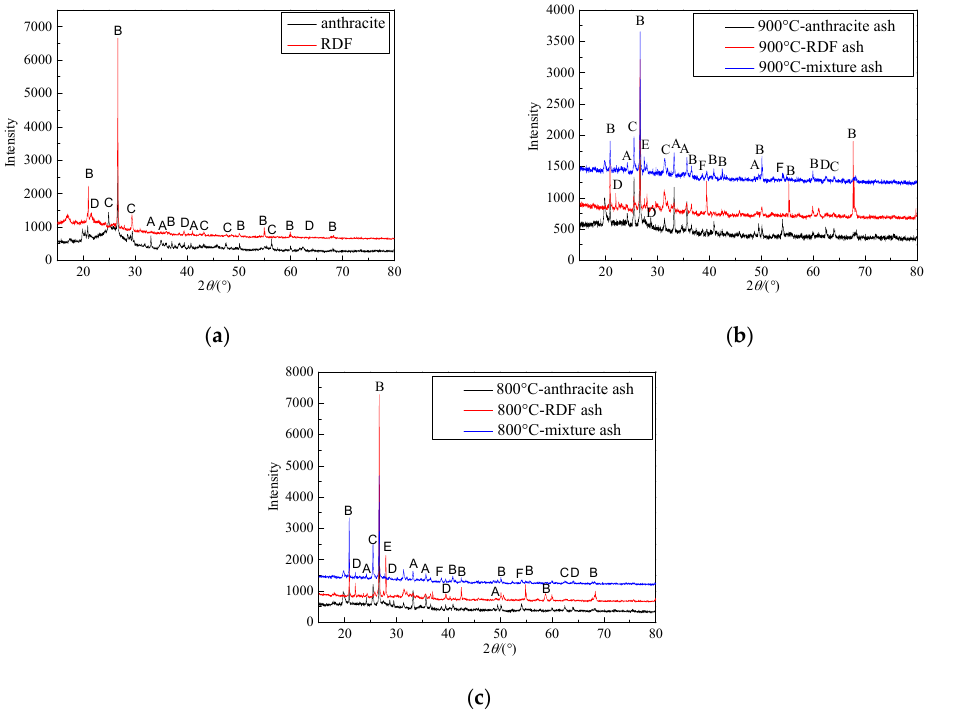
Figure 10. XRD analysis of fuels and different ashes: ( a ) original fuels; ( b ) ash at 900 °C; ( c ) ash at 800 °C, A-Fe 2 O 3 , B-SiO 2 , C-CaSO 4 , D-CaCO 3 , E-CaAl 2 Si 2 O 8 , and F-CaO.